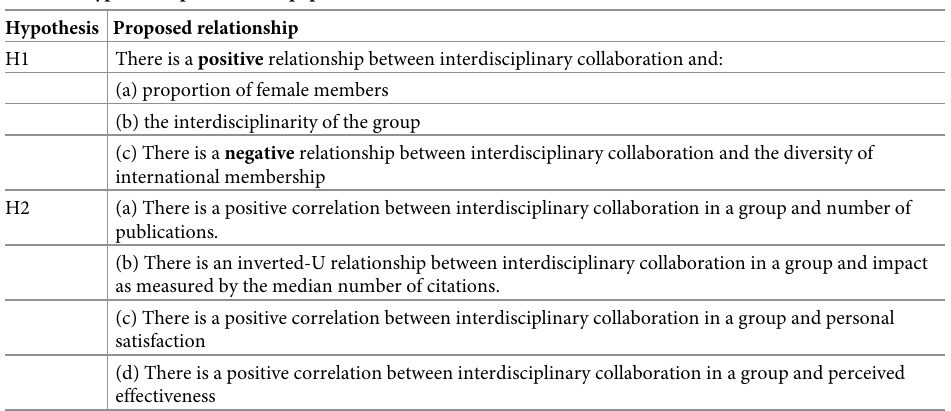
Table 1. Hypotheses posed in this paper. Hypothesis Proposed